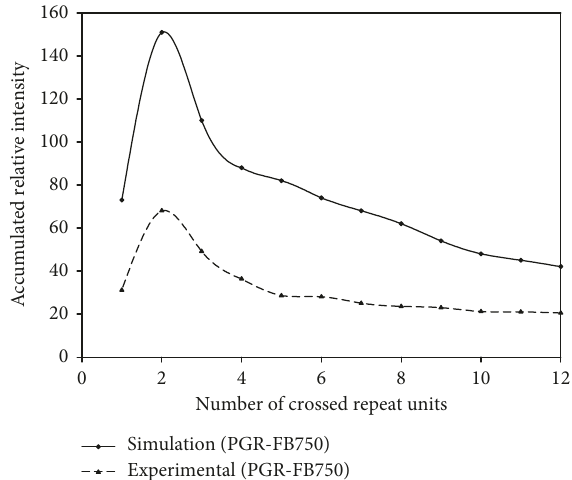
Figure 17: Comparison of simulation and experiment for side-illumination according to number of crossed repeat units.